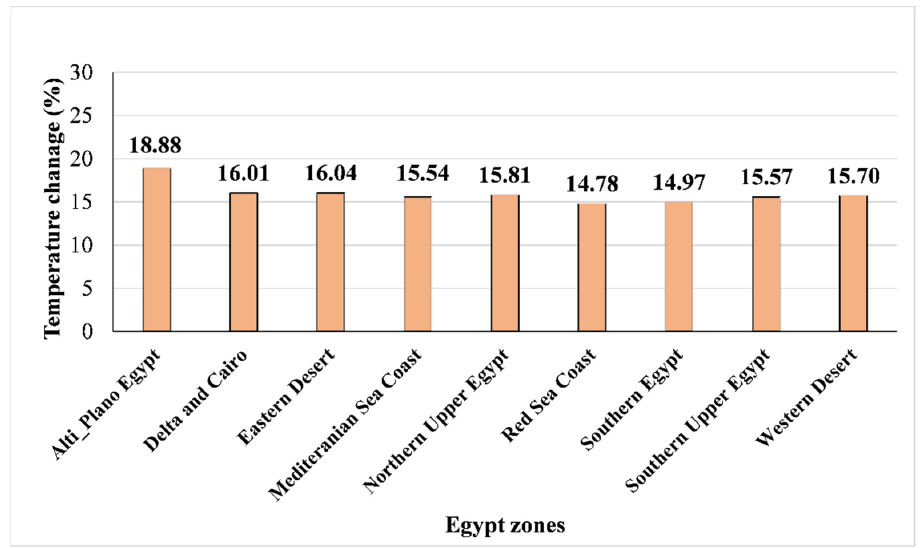
Figure 9. The zonal temperature changes in Egypt between the past period (1950–2014) and the future period (2015–2099), considering only the months from March to May.